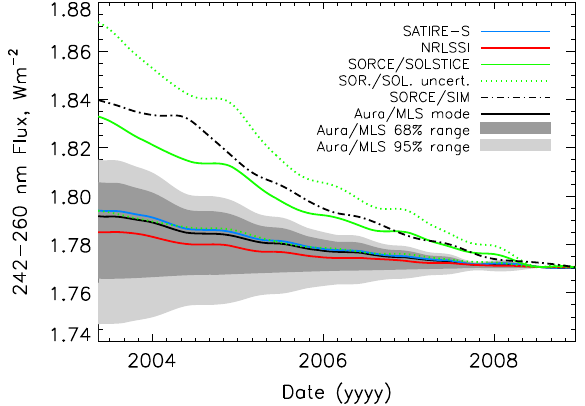
Fig. 4. The Aura/MLS posterior distribution at 242–260 nm, determined using the statistics presented in Figure 3, plotted as a timeseries for cycle 23, between 2003 and 2008. The mode is the solid black line, with the 68% range in dark grey and 95% range in light grey. Also shown are SATIRE-S (blue), NRLSSI (red), SORCE/SOLSTICE (green, solid line) with the SORCE/SOLSTICE uncertainty range (given by the green dotted lines) and SORCE/SIM (black, dot-dashed line). The absolute values of all datasets have been adjusted by adding the difference at the solar minimum in December 2008 so all datasets have the same value at this time. All timeseries have been